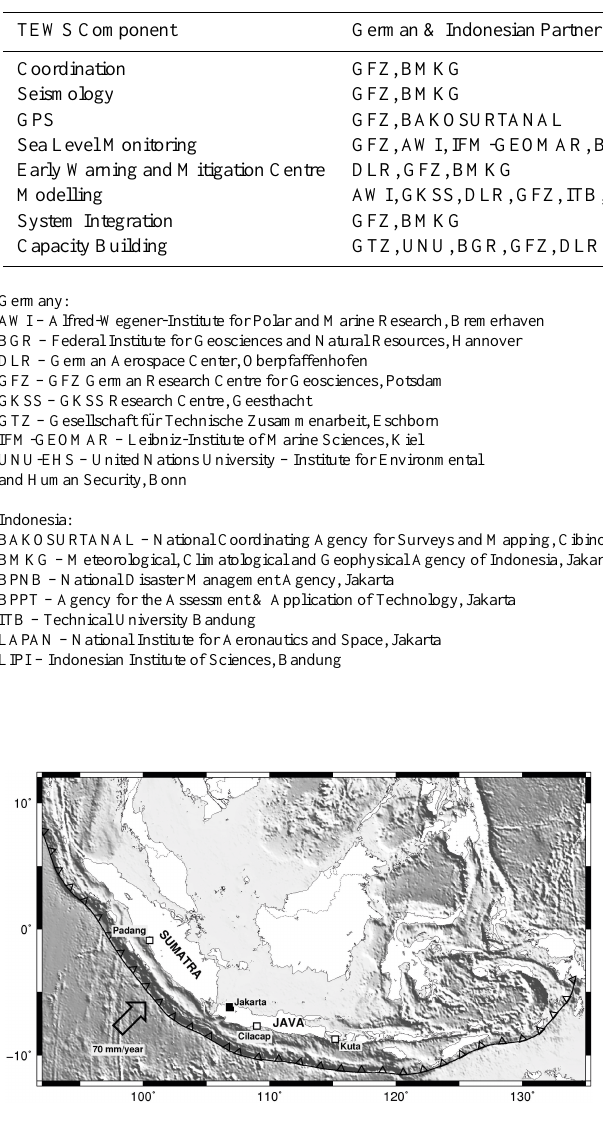
Fig. 1. The Sunda Arc is a major active plate boundary, where the Indo-Australian Plate is subducted at a speed of ∼ 7cm/y under the Eurasian Plate. The subduction zone (Sunda Arc) extends from the north of Sumatra to the island of